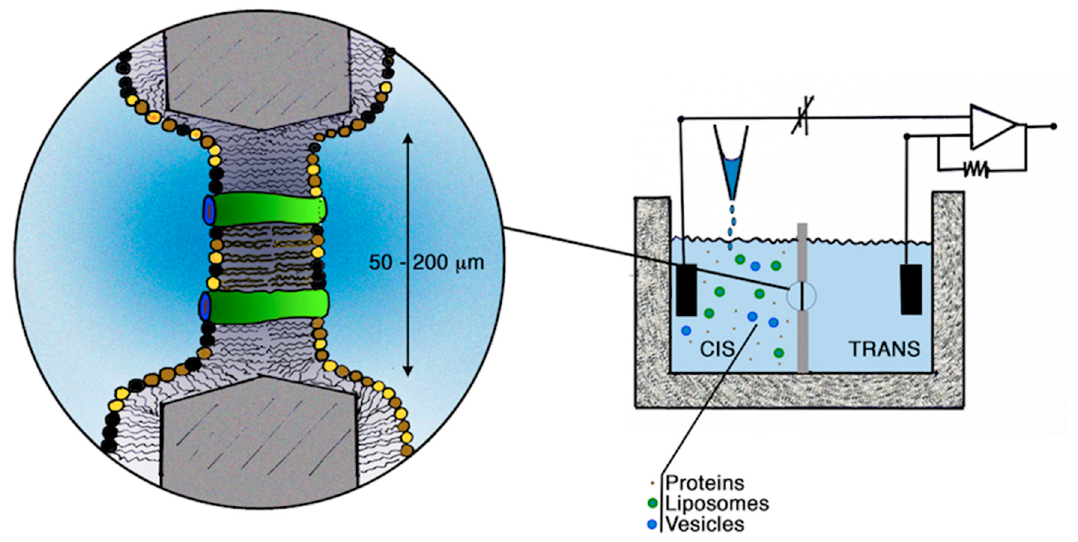
Figure 1. Schematic representation of a planar lipid bilayer system. Left: Solvent-free planar lipid membranes (PLM) (also called folded bilayers) are typically formed across a hole (~50–200 µ m) present in a thin Teflon septum dividing two distinct compartments drilled in a Teflon chamber. The lipids are dissolved in n-alkane solvents (typically n-hexane) and spread at the air–water interface of the ionic solutions present in both compartments. The lipid bilayer is formed by the spontaneous apposition of the hydrocarbon chains of the monolayers when the liquid levels are simultaneously raised above the aperture as described by [56]. Alternatively, planar bilayers can be formed by dissolving the lipids in n-decane that can be painted or brushed onto a larger (~1 mm) hole to form so-called painted membranes or black lipid membranes (BLM) [57]. Unfortunately, there is some concern about the possibility that some n-decane molecules remain in the bilayer affecting the properties of the transport proteins. Improved techniques have recently been developed to obtain more stable and high-performance lipid bilayers to study channels/transporters under conditions as close to natural conditions as possible (for a review, see [58]). Right: Proteins can be directly added to the monolayer(s); however, this approach frequently destabilizes the formation of the folded bilayers; as an alternative they can be added to the bath solution of the cis (as well as the trans) compartment(s) pending the stochastic interaction with the bilayer and the subsequent incorporation. Furthermore, proteins can be incorporated into amphiphilic spherical systems (see Figure 2), such as liposomes or membrane vesicles (here shown not to scale) operating as protein carriers to the bilayer. The electrical properties of the protein enriched bilayer can be investigated by means of Ag/AgCl electrodes that connect the chamber compartments to the headstage of a patch-clamp amplifier. The ion transport properties of the channels/transporters result in variations of the very tiny current flowing through the hydrophobic lipid bilayer almost impermeable to the ionic fluxes. The currents are typically recorded under voltage-clamp conditions controlled by a PC: Single channel transitions or macroscopic currents are recorded depending on the number of channels/peptides incorporated into the lipid bilayer